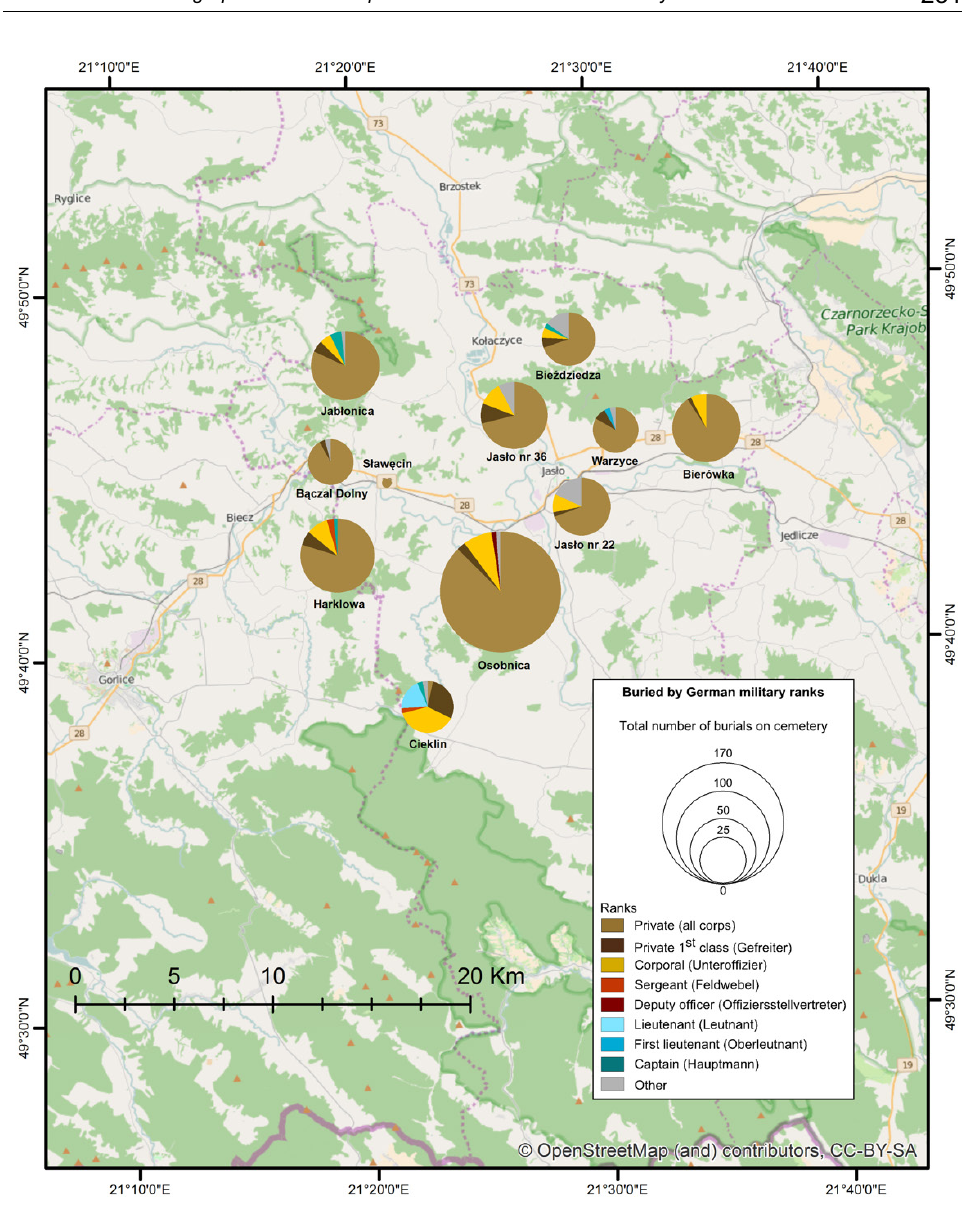
Fig. 4. Buried soldiers of the German army by military